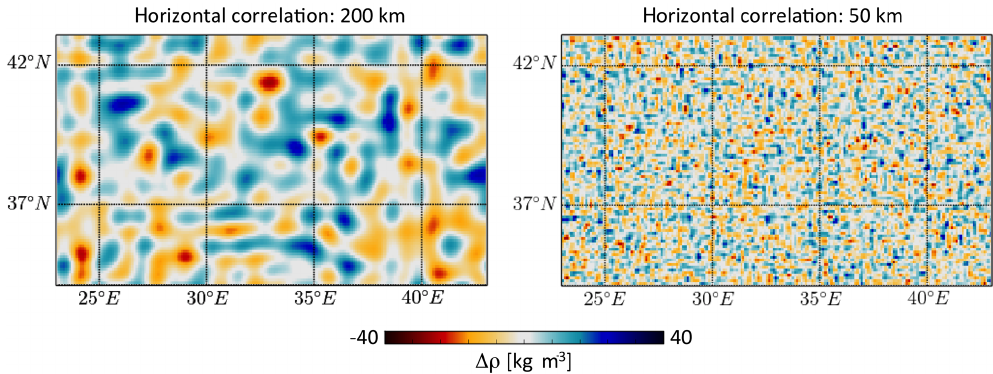
Figure 2. Realisations of random density variations. Left: 200km lateral correlation length, 20km vertical correlation length. Right: 50km lateral correlation length, 10km vertical correlation length.